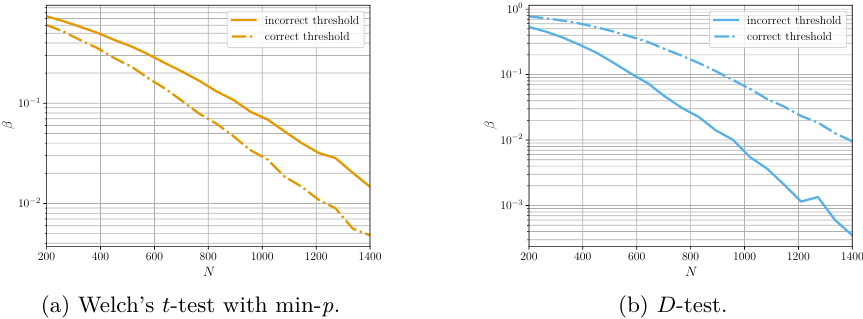
Figure 9: Detection rate errors due to incorrect signal independence assumption based on simulated traces with the covariance matrix Σ 2 and SNR = 0 .